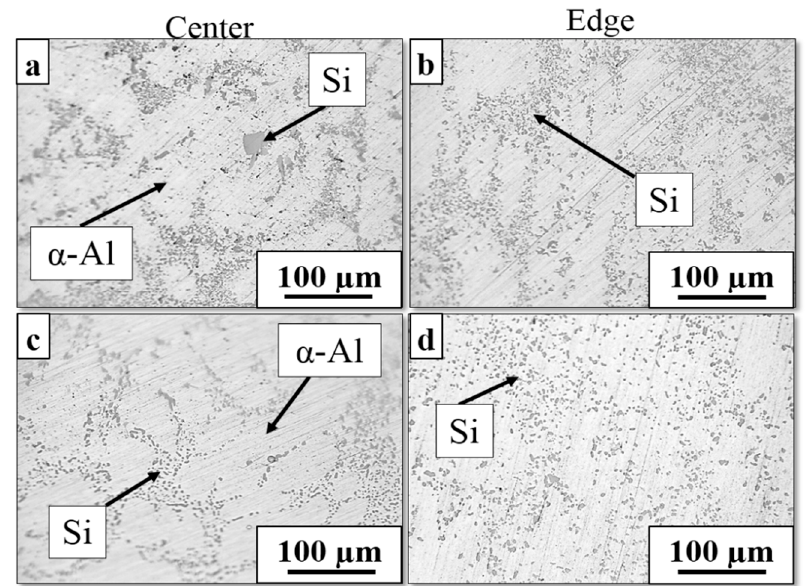
Figure 3. Microstructure of the HPTed A356 Al alloy pre-T6 at the ( a ) centre and ( b ) edge, and post T6 at ( c ) centre and ( d ) the edge by 0.75 turns.